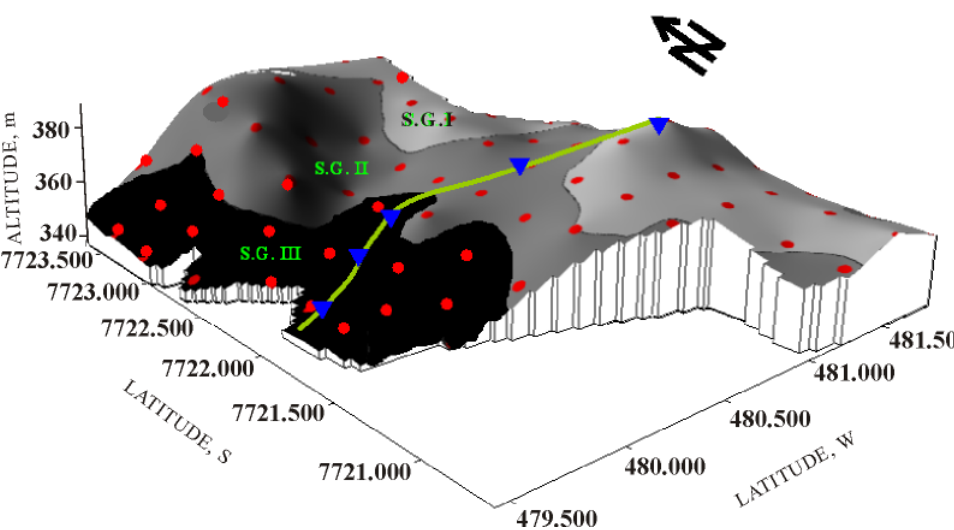
Figura 1. Modelo de Elevação Digital de uma área de 530 ha, mostrando as superfícies geomórficas (S.G.I, S.G.II, S.G.III) mapeadas na profundidade (0,80–1,00 m), a transeção da área mapeada ( ------- ), os locais de amostragem das trincheiras ( ) e os pontos laterais de amostragem (